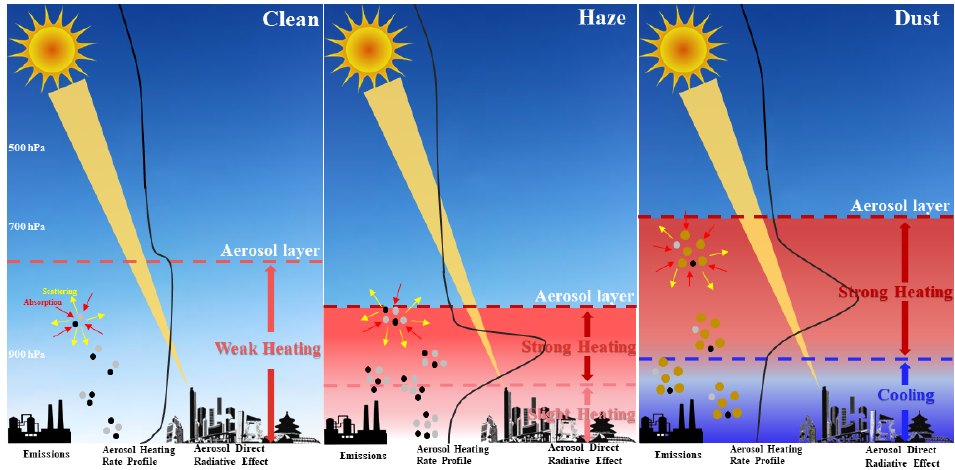
Figure 9. Diagram of the aerosol direct radiation during different HPEs proposed in this study.